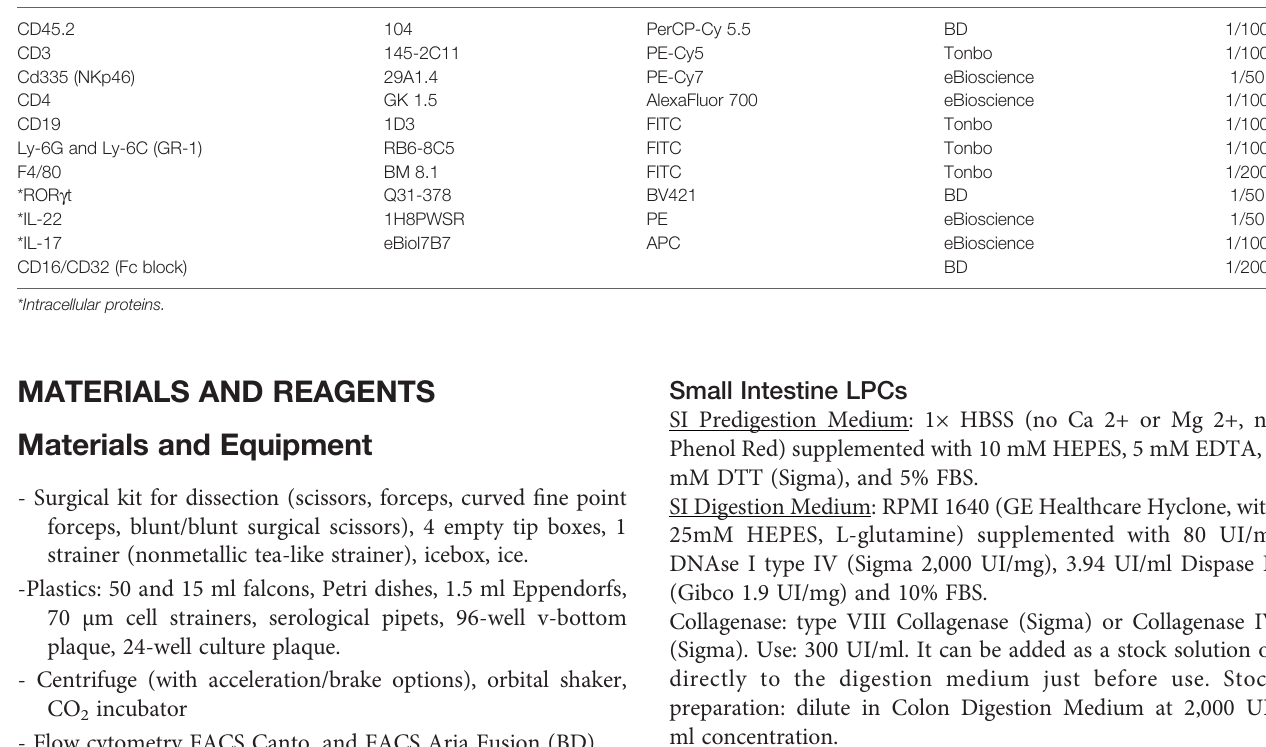
TABLE 3 | Protein markers for analysis of ILC3-expressing cytokines. Antigen